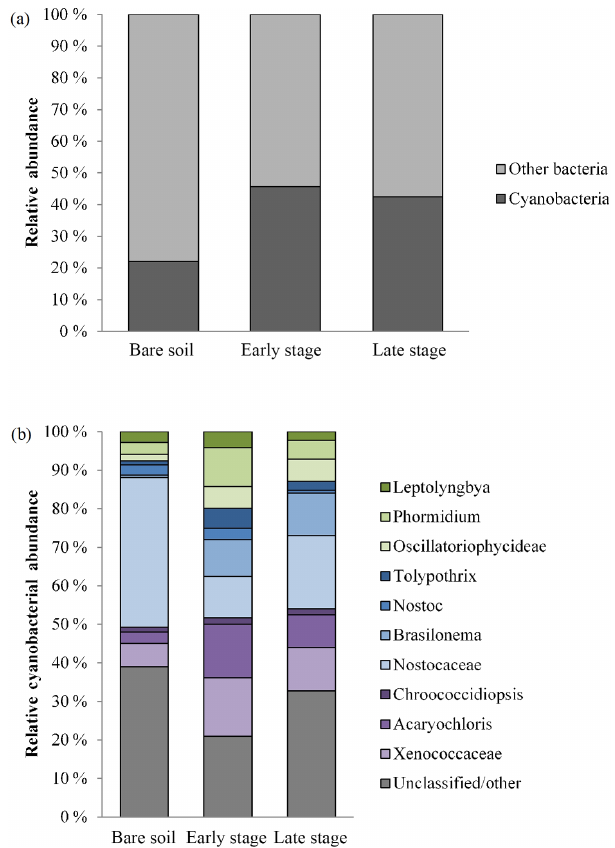
Figure 6. (a) Relative abundance of cyanobacteria to other bacte- ria within bare soil and early- and late-stage biocrusts. (b) Abun- dance of cyanobacterial genera and groups. Green: simple filamen- tous types, blue: heterocystic types, purple: unicellular. grey: un- classified or other (includes chloroplasts).